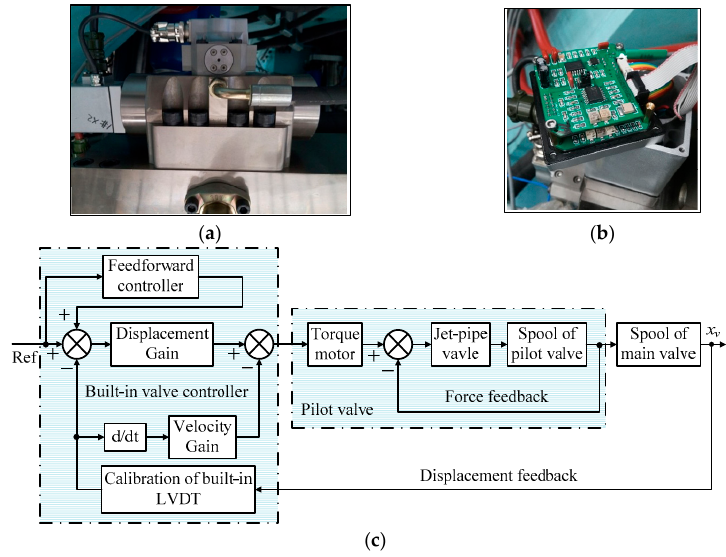
Figure 3. The developed servo valve. ( a ) The three-stage servo valve; ( b ) The servo valve controller; ( c ) The schematic of the three-stage servo